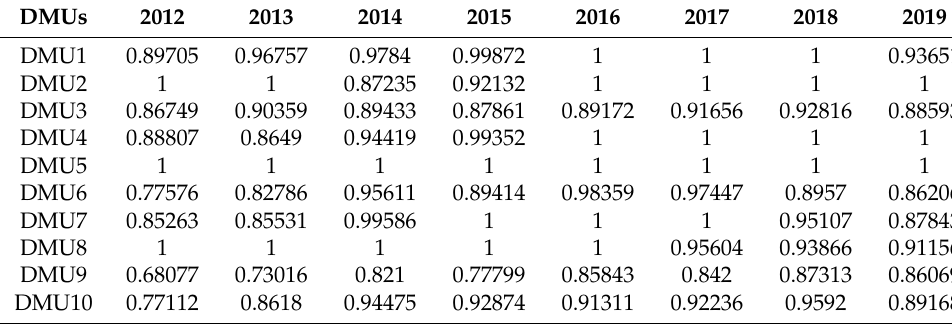
Table 8. The efficiency scores for DMUs in the past years (2012–2019).